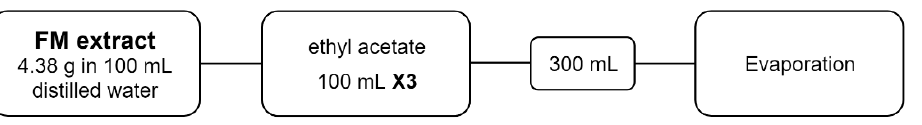
Figure 2. Fractionation diagram of flowers macerate extract.